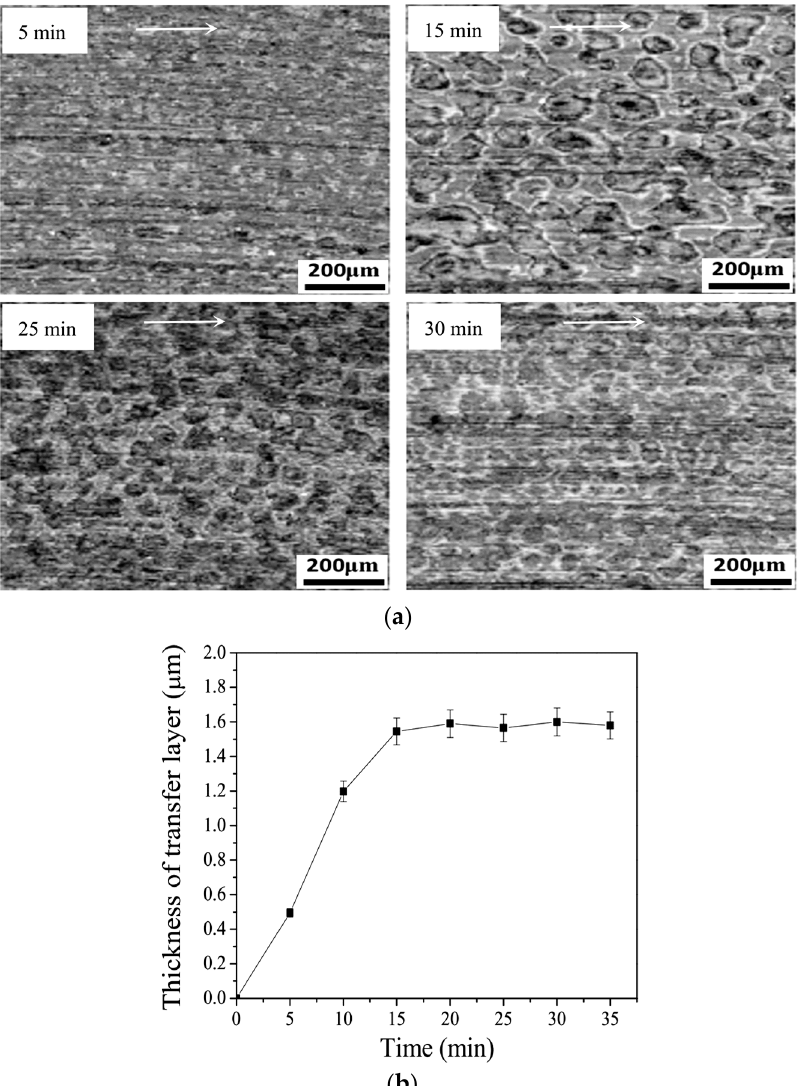
Figure 10. ( a ) Surface of the counterface at different times; ( b ) Transfer layer thickness over time.